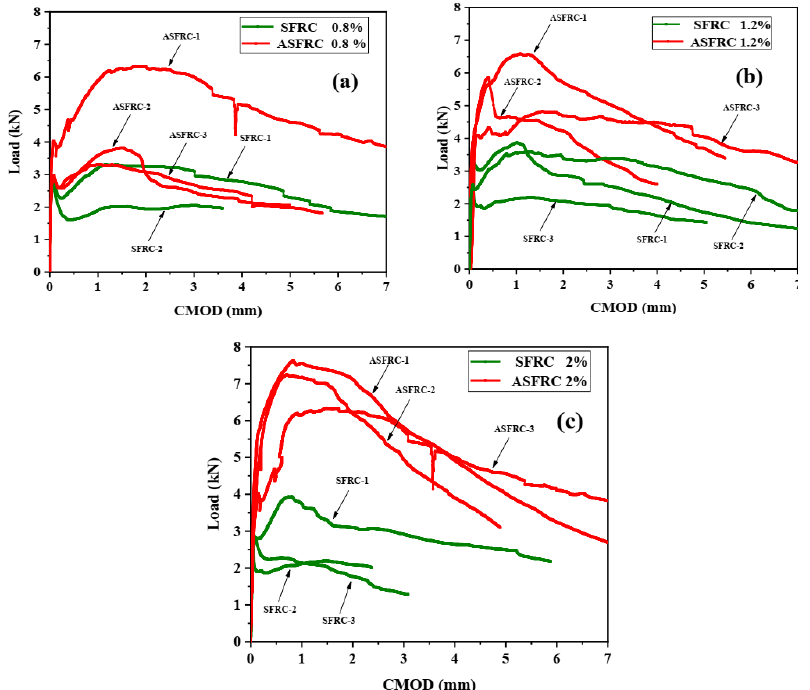
Figure 3. Load-crack mouth opening displacement (CMOD) for ASFR and SFRC at various volume fractions: ( a ) 0.8% of fiber volume fraction, ( b ) 1.2% of fiber volume fraction and ( c ) 2% of fiber volume